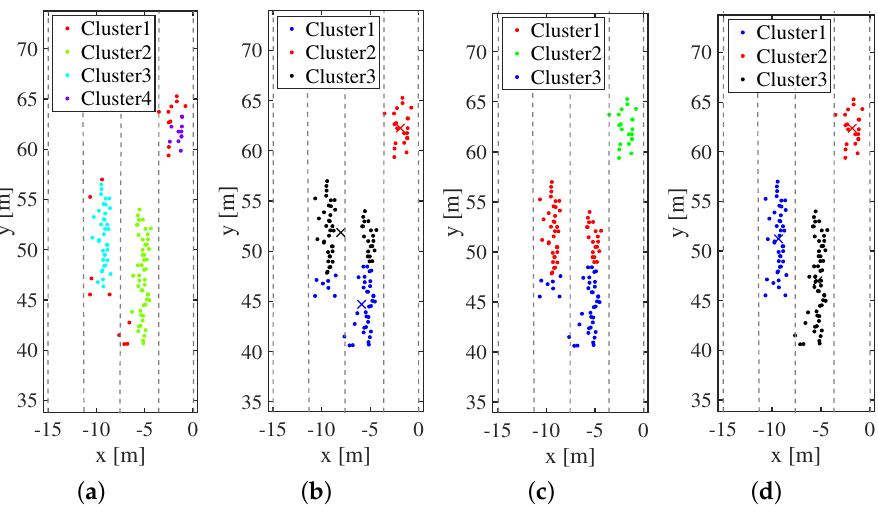
Figure 9. The clustering results of each algorithm: ( a ) DBSCAN; ( b ) FCM; ( c ) K-Means; and ( d ) SDPFC. Scene 2: There are three vehicles with a close driving distance on the straight four-lane highway. The lateral distance between the two vehicles is very close and the large vehicle covers the small vehicle. The other one is farther away from the two vehicles, as shown in Figure 10. At this time, the radar returns a total of 115 valid sampling points, and their distribution is shown in Figure 11.